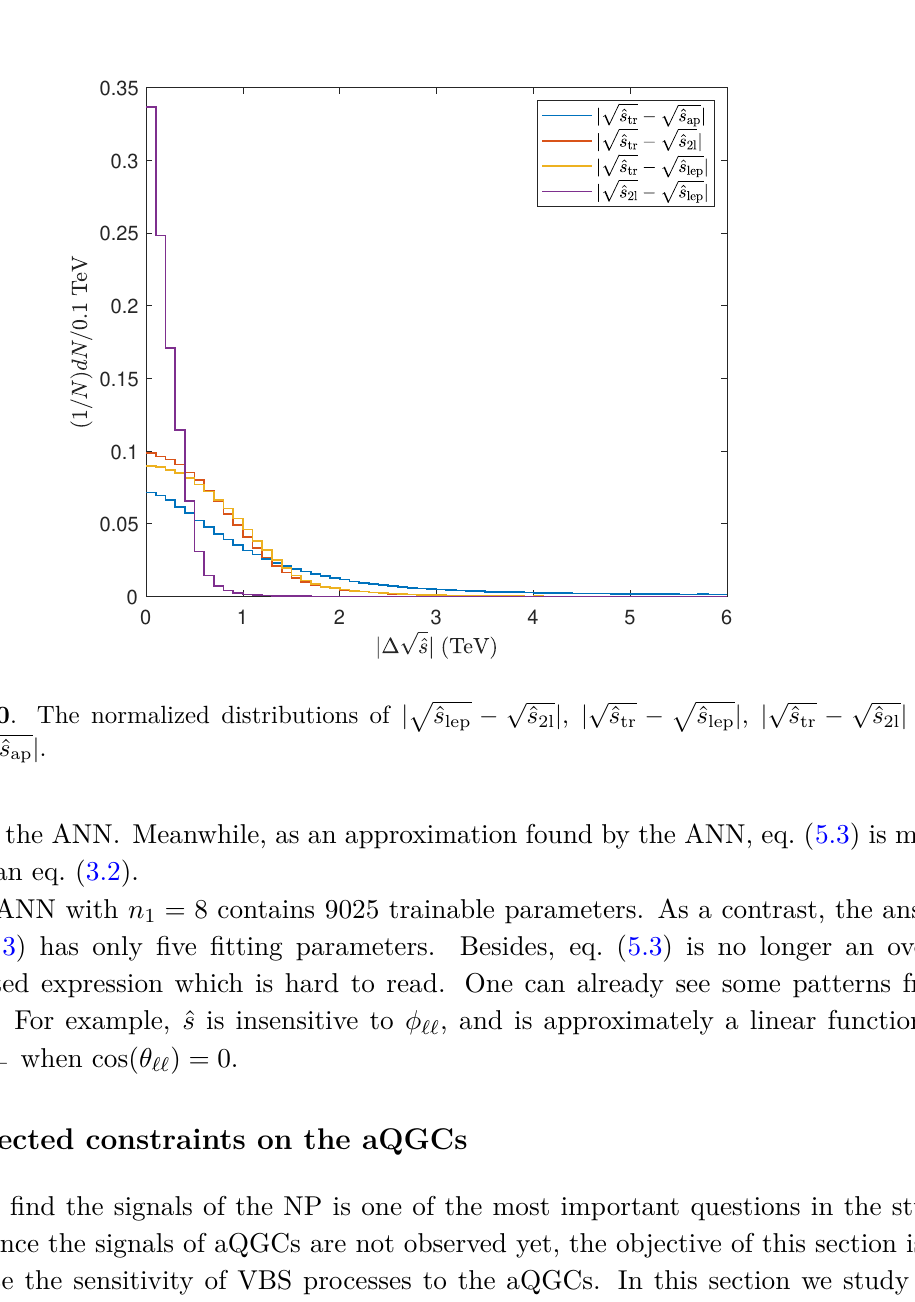
Figure 10 . The normalized distributions of | p ˆ s lep − |√ ˆ s tr − p ˆ s ap |